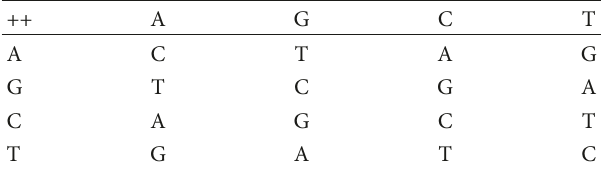
Table 2: Addition (++) operation.